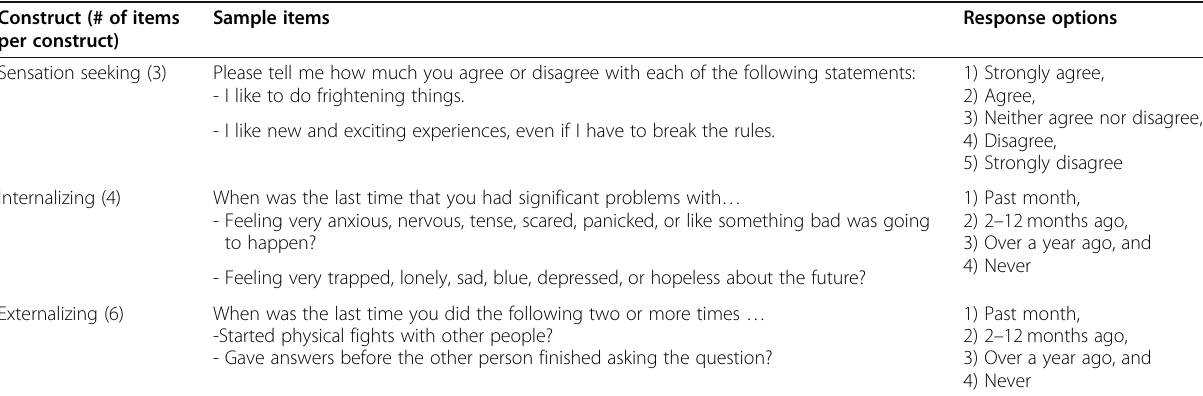
Table 1 Sample survey items and response options comprising psychological constructs of sensation-seeking, internalizing, and